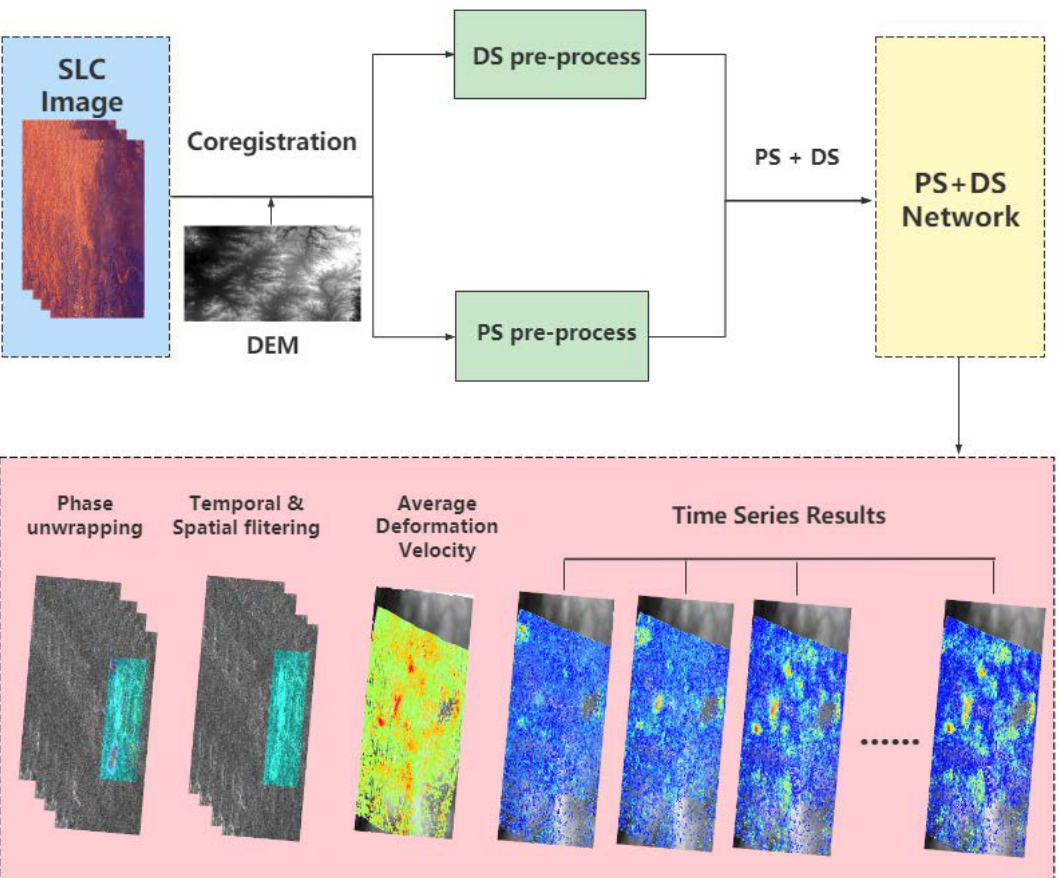
Figure 3. CS-InSAR data processing flow.